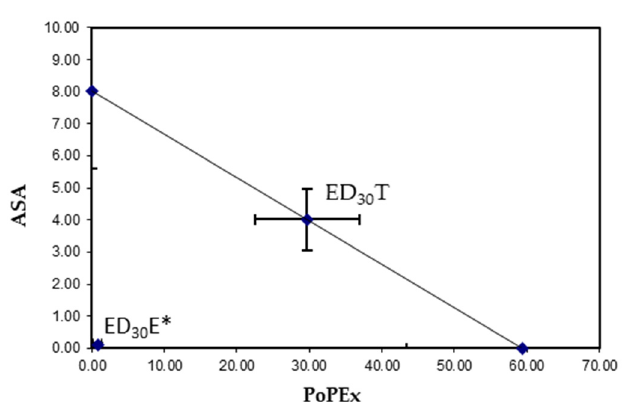
Figure 3. Isobologram of the interaction between acetylsalicylic acid (ASA) and pomegranate peel extract (PoPEx) in the 2% formalin test. The line between the X and Y axes represents the theoretical additive effect that the drug combination would have, the middle point of which is the theoretical additive point of the ED 30 T values of the individual drug. The experimental point (ED 30 E) is observed below the line, close to 0, * = a statistically significant synergistic effect versus ED 30 T ( p < 0.05).